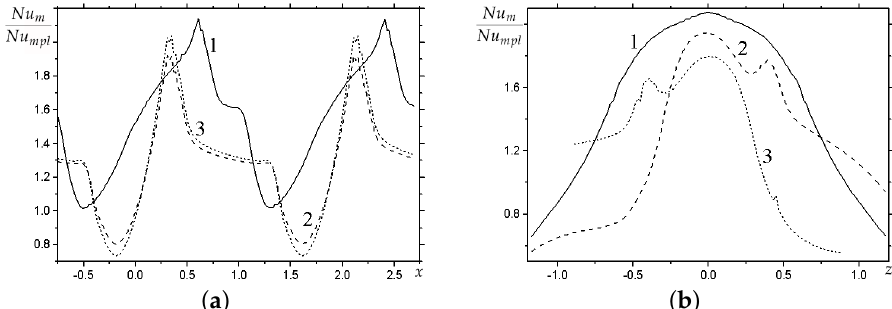
Figure 7. Relative heat transfer averaged over a strip with dimples in the longitudinal ( a ) and transverse ( b ) directions for oval (1) and spherical (2, 3) dimples. 1, 2— H z = 2.8;